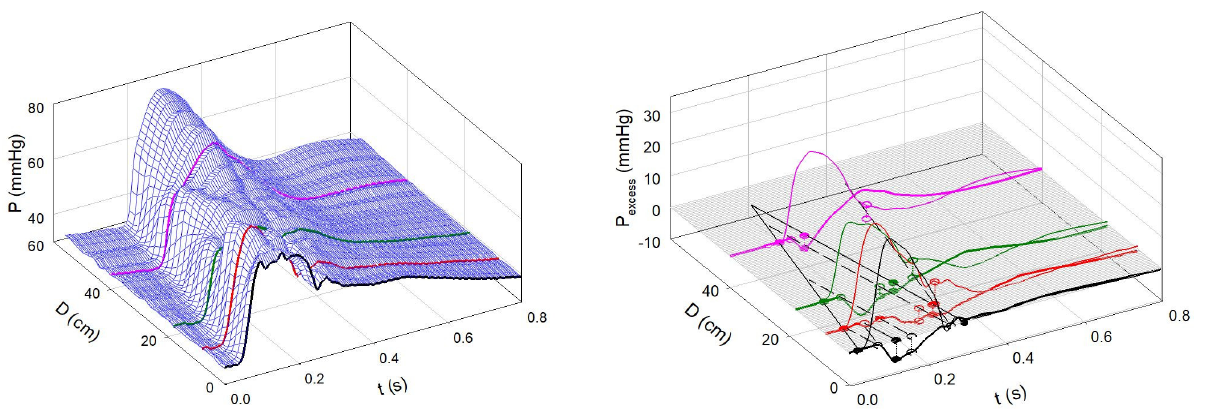
Figure 6. Infusion of NP. A: Measured aortic pressure plotted as a function of time and distance. Note that the contour is less regular than in Figure 4; B: path of the FCW and the reflected backward waves. Waves were reflected negatively from the descending aorta, a sub-diaphragmatic site near the renal arteries, and near the aorto-iliac junction and positively from a femoral artery site